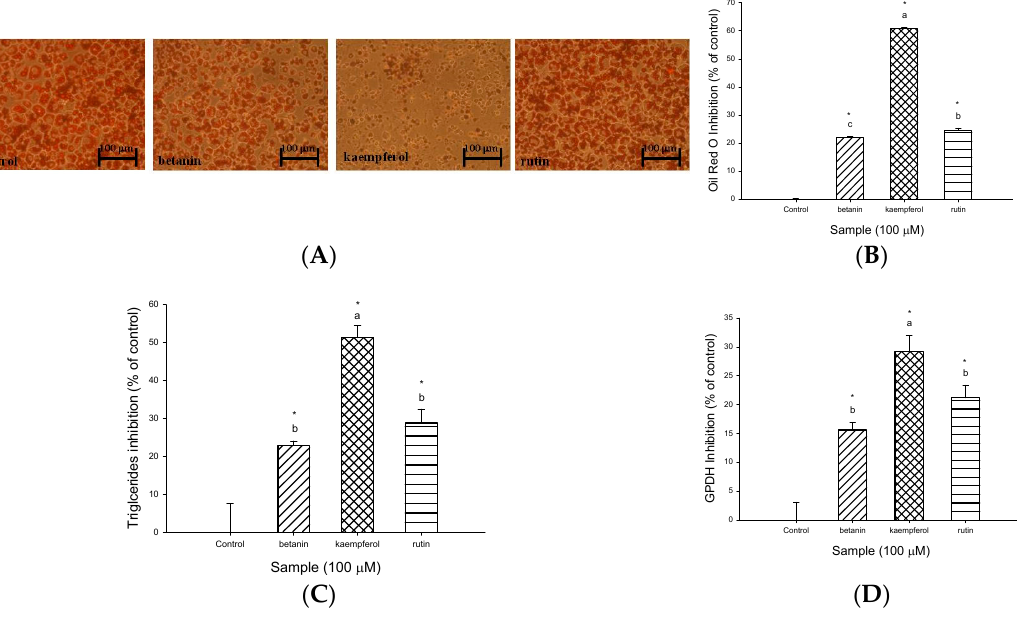
Figure 4. Effects of rutin, kaempferol and betanin on adipogenesis in 3T3 ‐ L1 cells. ( A ) The microscopic images of Oil red O ‐ staining of rutin ‐ , kaempferol ‐ or betanin ‐ treated 3T3 ‐ L1 cells. ( B ) Oil red O ‐ staining of rutin ‐ , kaempferol ‐ or betanin ‐ treated 3T3 ‐ L1 cells. 3T3 ‐ L1 cells were incubated with 100 μ M of rutin, kaempferol or betanin, respectively, for 72 h at 37 °C in 5% CO 2 incubator. ( C ) Rutin ‐ , kaempferol ‐ or betanin ‐ mediated suppression of intracellular triglyceride levels of 3T3 ‐ L1 cells. 3T3 ‐ L1 cells were incubated with 100 μ M of rutin, kaempferol or betanin, respectively, for 72 h at 37 °C in 5% CO 2 incubator. ( D ) Effect of 100 μ M of rutin, kaempferol or betanin on GPDH activity in 3T3 ‐ L1 cells. The cells were incubated with 10–500 μ g/mL of rutin, kaempferol or betanin, respectively, for 72 h at 37 °C in 5% CO 2 incubator. Data are expressed as the mean ± SD of three independent experiments. * ( p < 0.05), compared to the control. Values in each concentration with different superscript letters are significantly different ( p < 0.05).